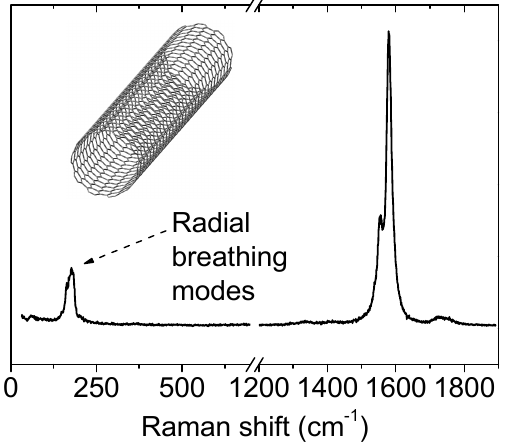
Figure 13. Example of carbon nanotube Raman spectrum ( λ 0 = 514 nm).